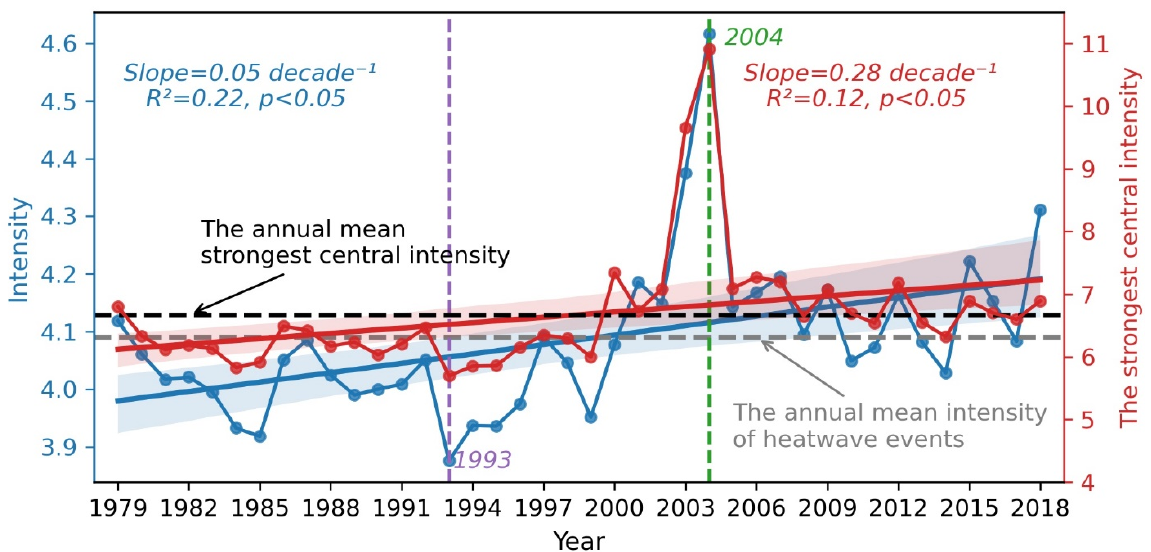
Figure 6. Variations in intensity and the strongest central intensity of heatwave events in the 1979–2018 period across China. The black and gray horizontal dashed lines denote the annual mean intensity and the strongest central intensity, respectively, of heatwave events during the study period; the shadowed area in blue and red represents 95% confidence interval for the fitting line of intensity and the strongest central intensity, respectively; the vertical line in purple and green are the minimum and maximum year of intensity and the strongest central intensity.